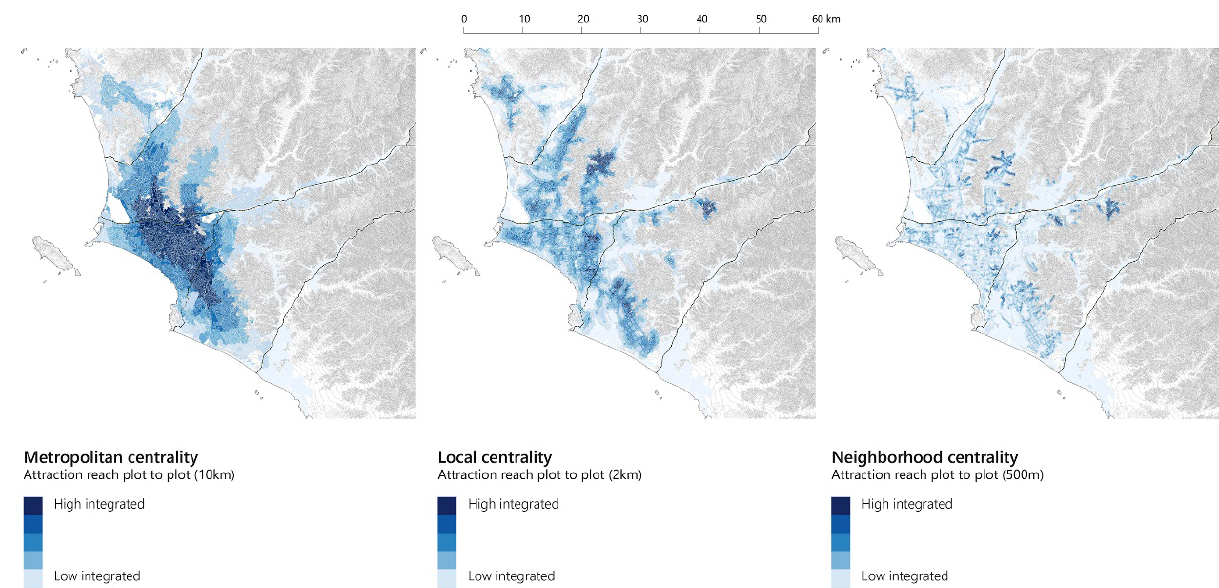
Figure 5. Relationship between the centrality structure and scale in Metropolitan Lima. Source: Authors, based on data from Municipality of Lima (2013a) and Open Street Map (2019).